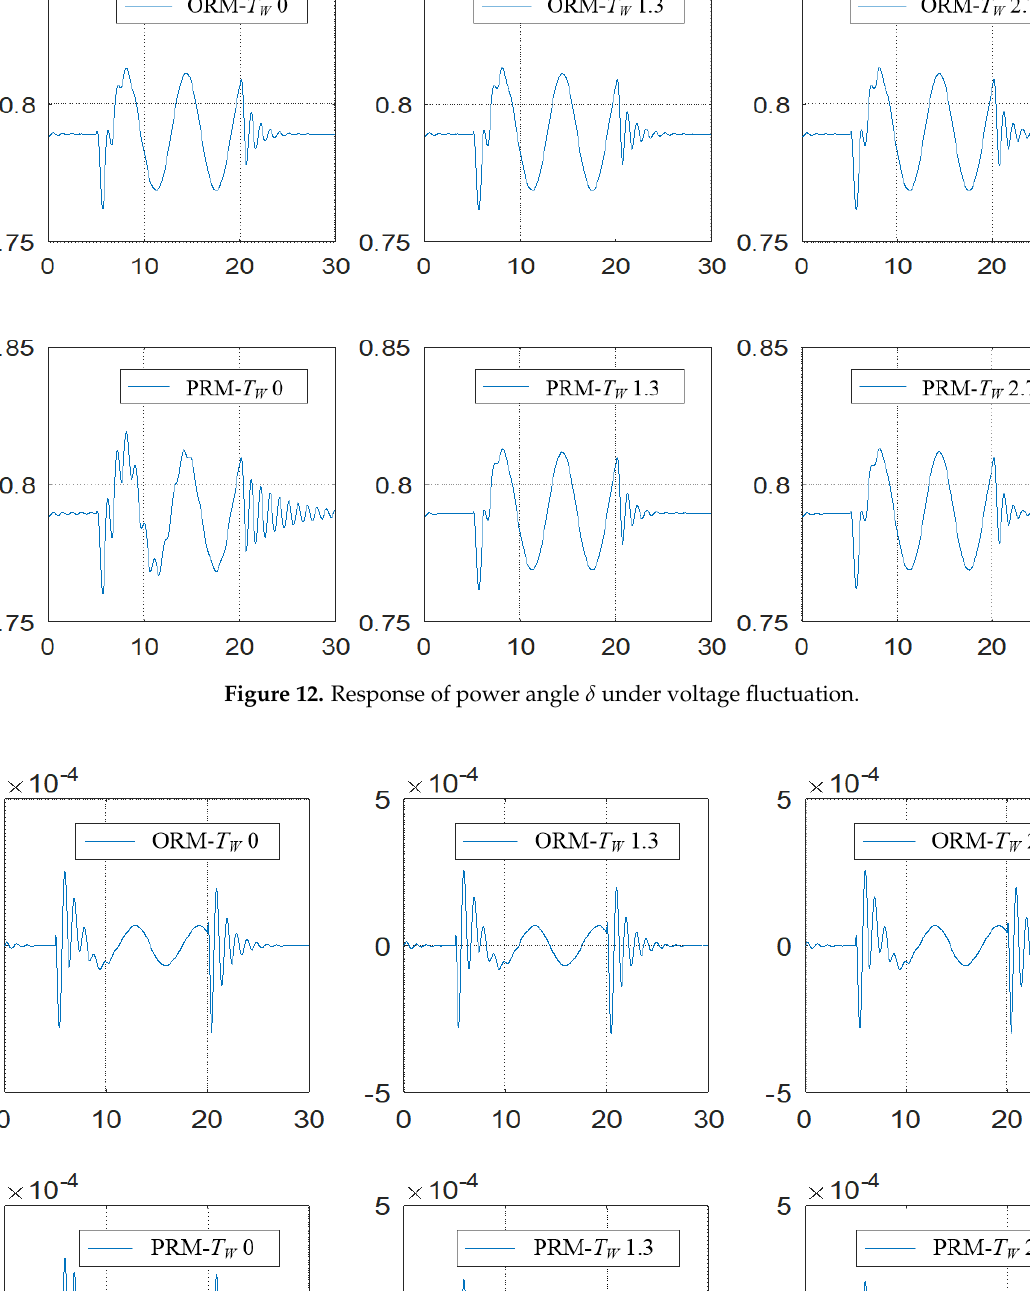
Figure 11. Response of hydroturbine output torque m t under voltage fluctuation.